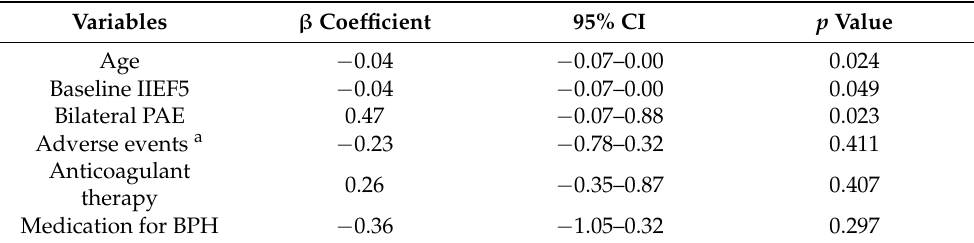
Table 5. Multivariate analysis: factors independently associated with the IPSS-QoL score improve- ment at month 3 vs.